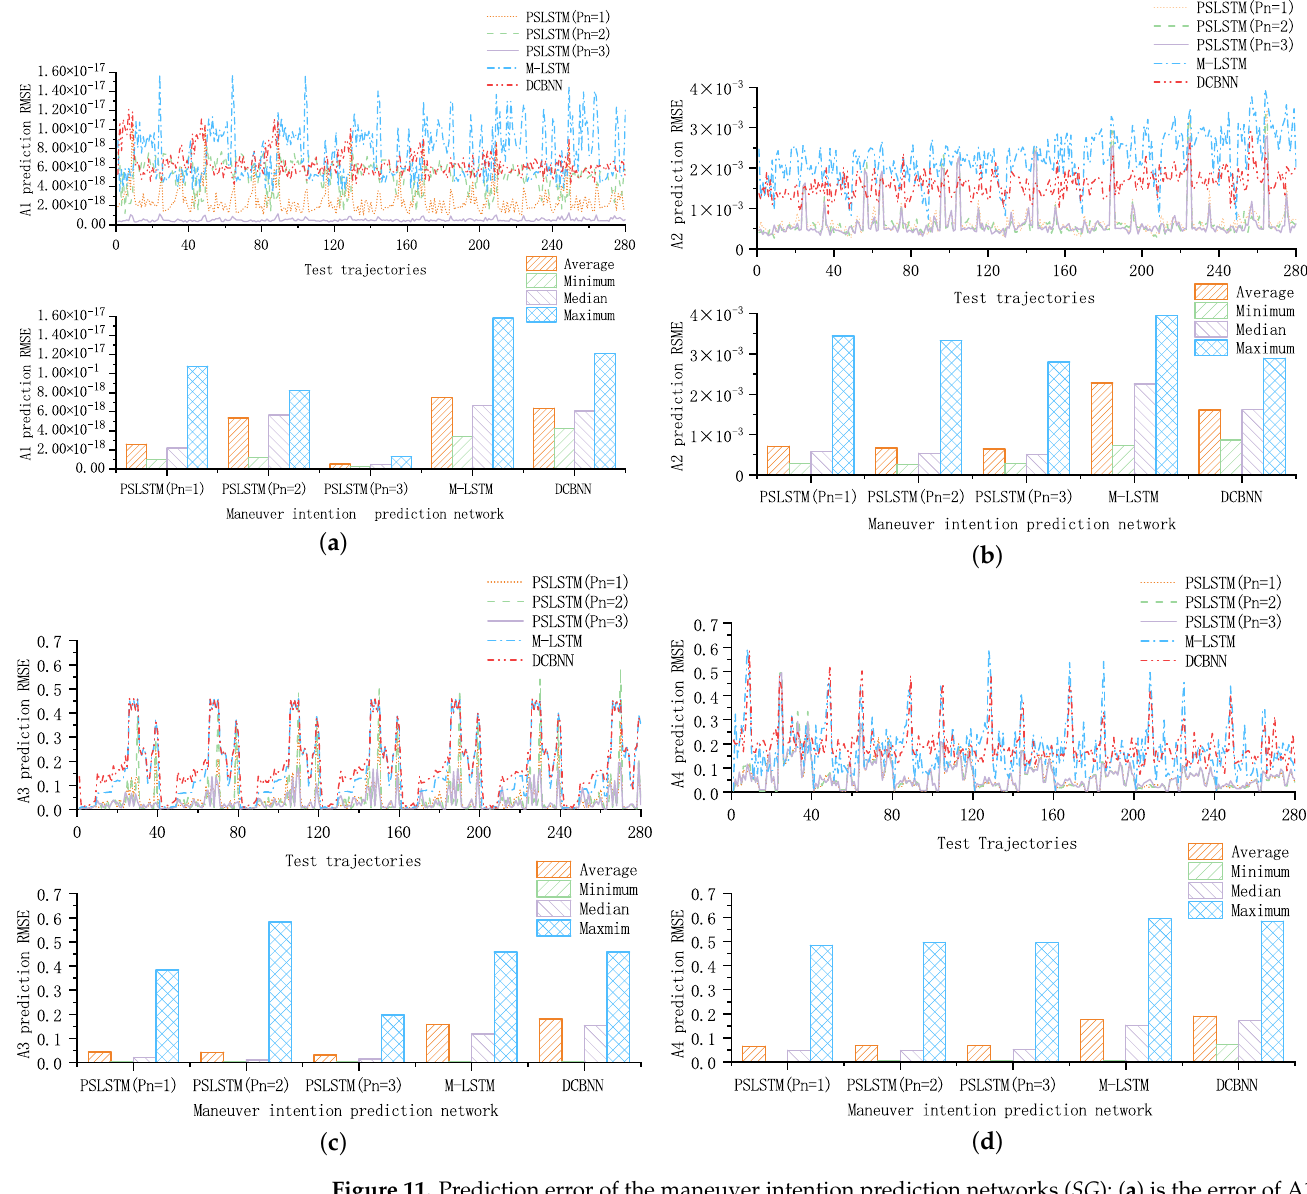
Figure 11. Prediction error of the maneuver intention prediction networks ( SG ): ( a ) is the error of A1 prediction, ( b ) is the error of A2 prediction, ( c ) is the error of A3 prediction, and ( d ) is the error of A4